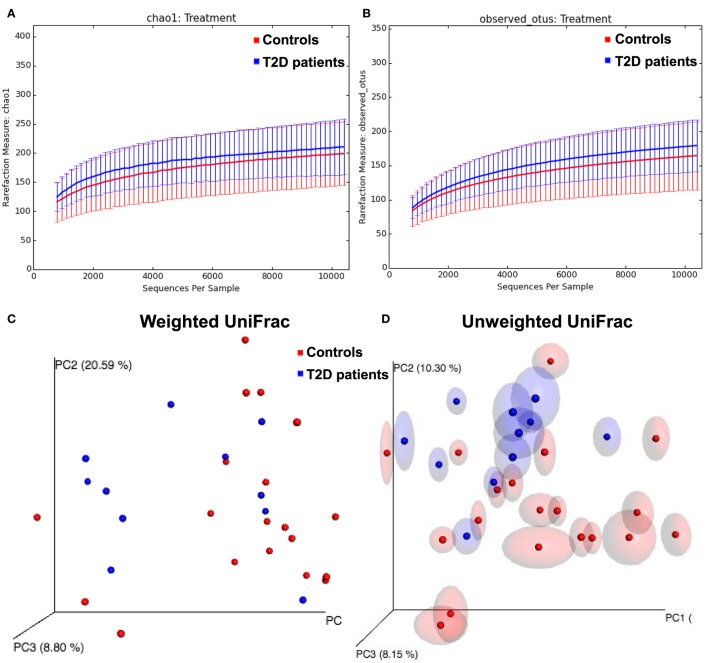
Alpha and beta-diversity in gut microbiota from type 2 diabetes (T2D) patients. (A,B) Rarefaction curves comparing the species richness, Chao1, and observed Operational Taxonomic Unit (OTU) numbers. (C,D) PcoA plots with weighted and unweighted UniFrac metric with Bonferroni’s correction.